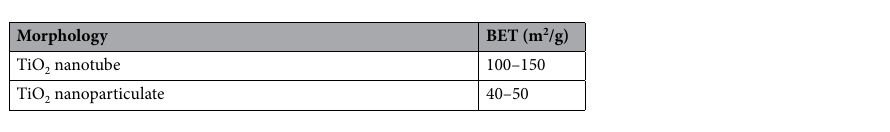
Table 2. The comparison of BET surface area between nanoparticle and nanotube film 68